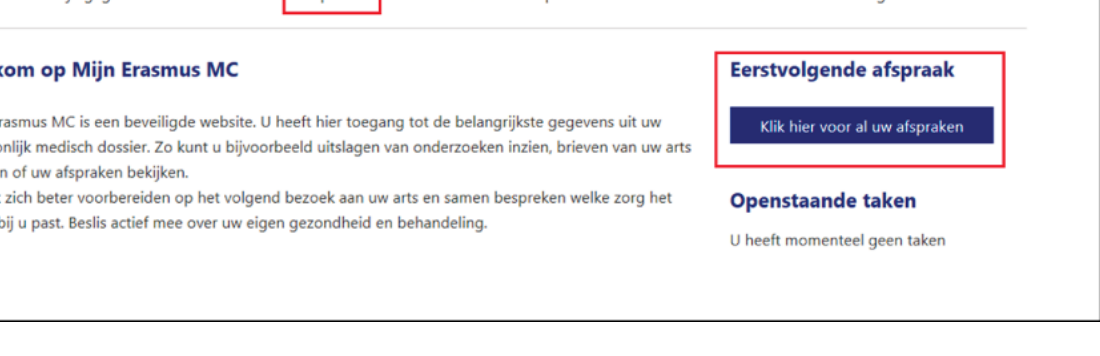
Figure 3. Didactic materials for health care